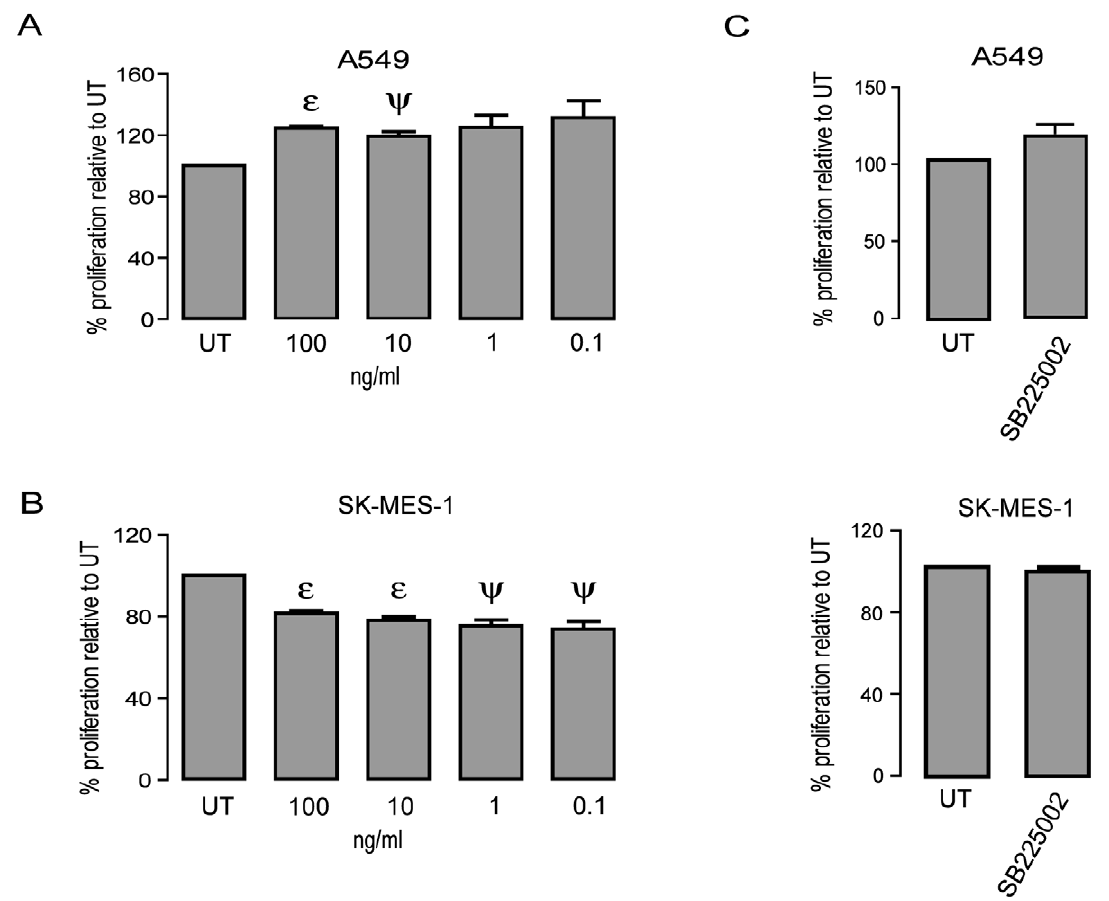
Figure 6. The growth effect of CXCL8 varies between NSCLC sub-type but is negated by neutralizing the CXCR2 receptor. A) Cell proliferation was examined by BrdU assay following 24–72 h treatment with CXCL8 in A549 (72 h post treatment) and SKMES-1 (24 h post treatment) cell lines. Only time points with significant data is shown. Data is represented as a percentage of the untreated control (UT), which was set to 100% and is expressed as mean 6 SEM. (n=3) ( e p , 0.01 – CXCL8 treatment vs. UT, y p , 0.05 – CXCL8 treatment vs. UT) B) Cell lines were treated with a selective CXCR2 antagonist (0.022 m M) for 1 h prior to the addition of CXCL8 and cultured for a period of 24 (SKMES-1) or 72 h (A549). Data is represented as a percentage of the untreated control (UT), which was set to 100% and is expressed as mean 6 SEM. (n=3).